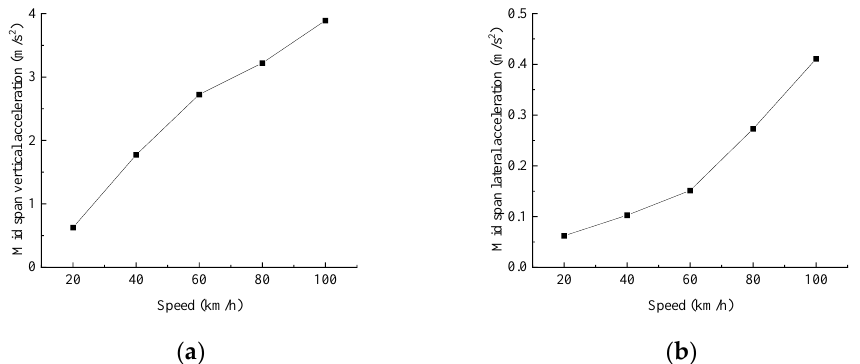
Figure 17. Mid-span acceleration response under different speed levels (unit: m/s 2 ): ( a ) Mid-span vertical acceleration. ( b ) Mid-span lateral acceleration.